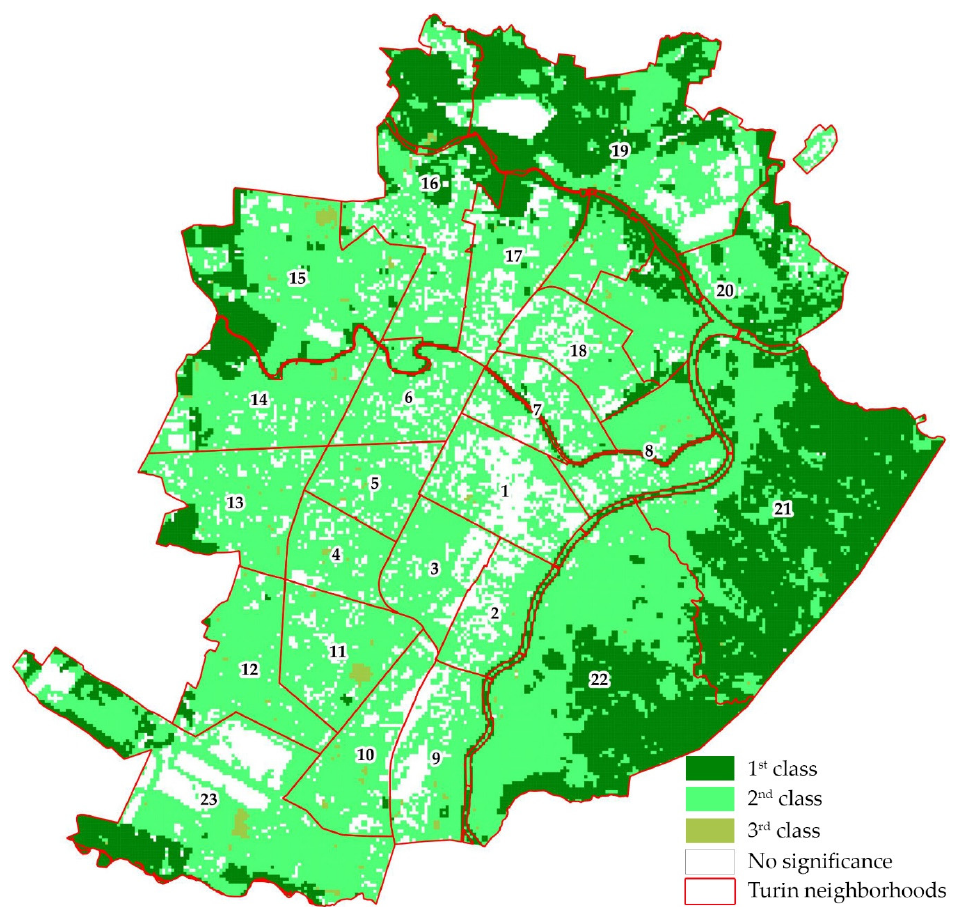
Figure 3. Provisioning and regulating services obtained by the Preliminary Assessment Method. Urban Ecosystem Services (UES) significance: 1st class: > 7.5; 2nd class: ≤ 7.5, > 3.0; 3rd class: ≤ 3.0, > 0.5; no significance: ≤ 0.5.